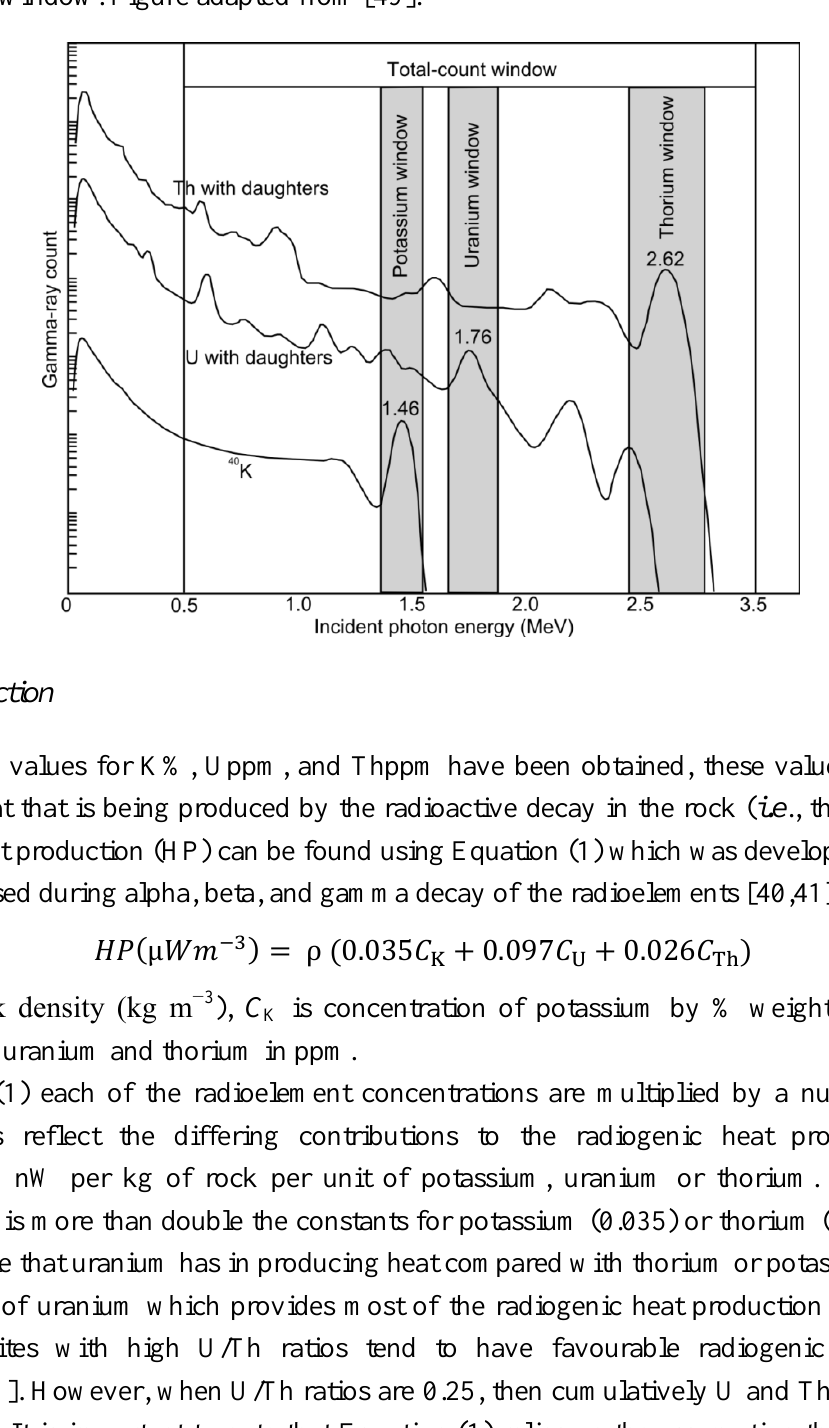
Figure 5. Figure showing typical counts of different energies produced by scattering of photons produced by the decay of thorium and uranium with daughters, and potassium. The distributions of energy photons demonstrate how thorium daughters produce photons in the uranium and potassium window and uranium daughters produce photons also in the potassium window. Figure adapted from